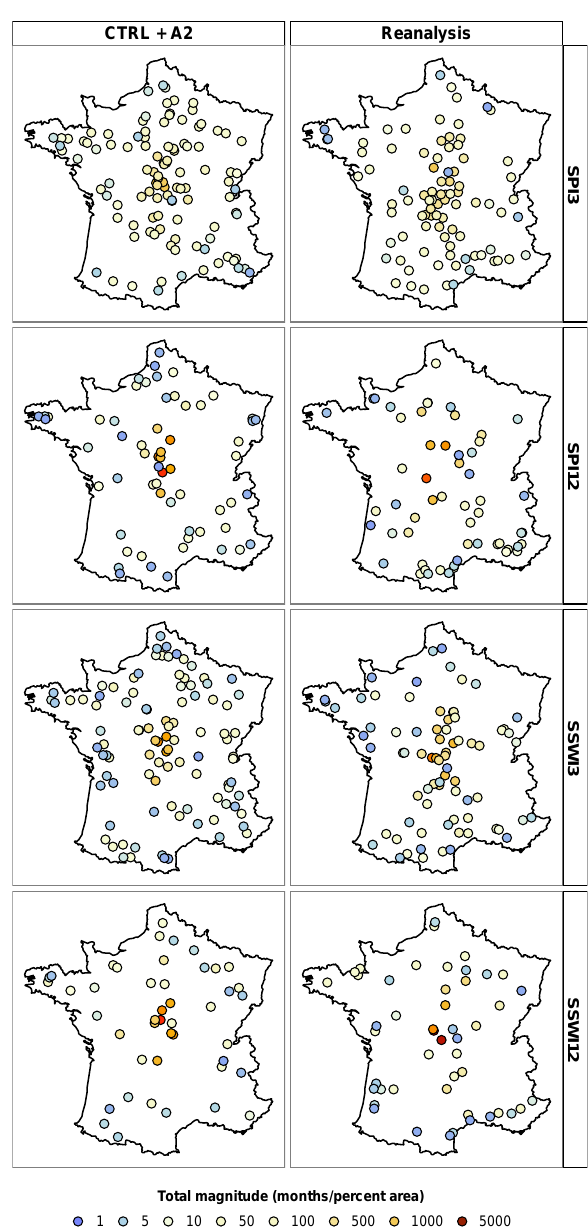
Fig. 5. Centroid of drought events identified over the 1958–2008 pe- riod, from the reanalysis (right) and from the (CTRL + A2) down- scaled ARPEGE run. Colors denote different classes of total mag- nitude. The different rows show all four drought indices.